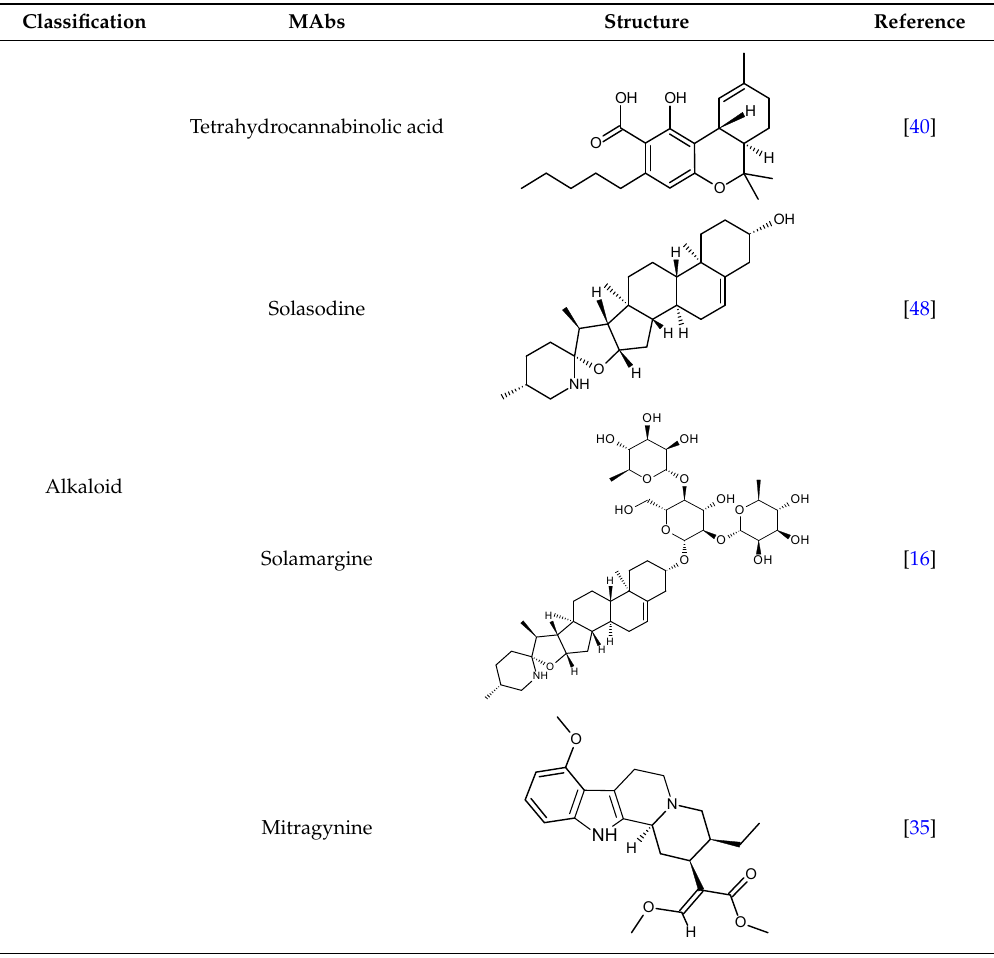
Table 2. Existing anti-MPNP monoclonal antibodies (MAbs).